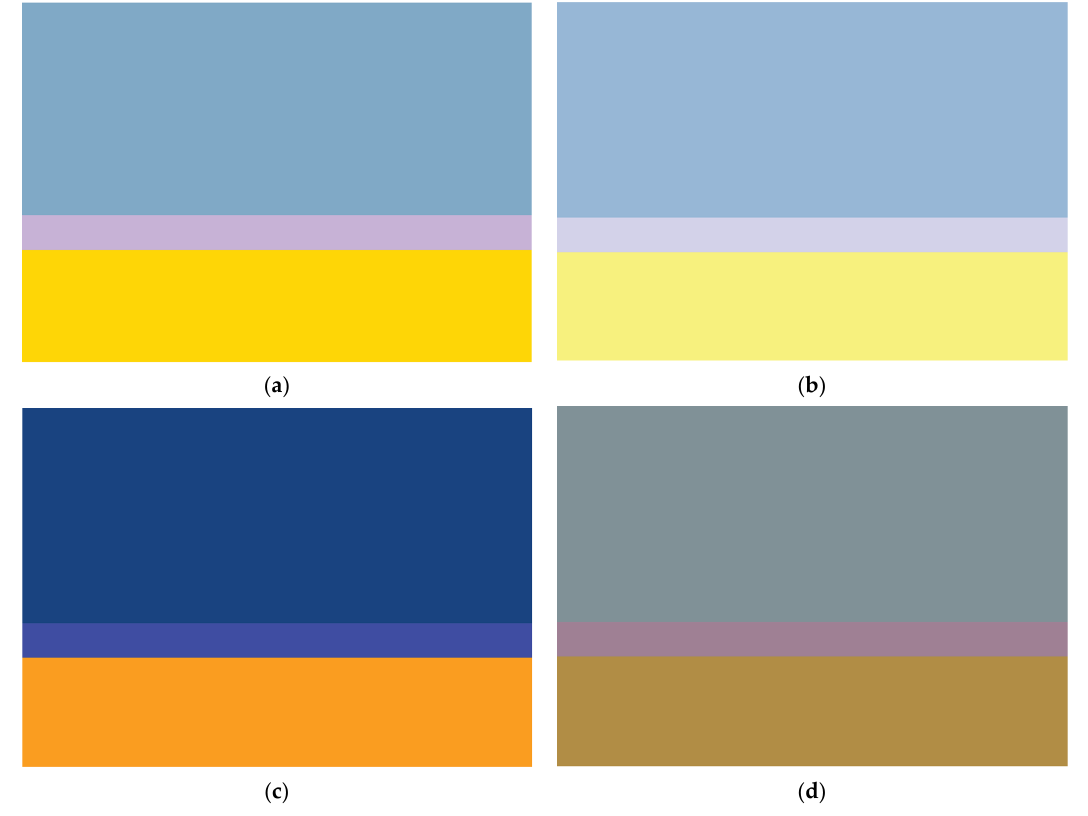
Figure 3. The sequentially first color charts in Sections I ( a ), II ( b ), III ( c ), and IV ( d ). As for hue, the main colors of the first three sections are fairly evenly distributed across the four quadrants of the color circle. Seven of them lie in the range between red and yellow (26.74 ≤ h° ≤ 71.83), six each fall between yellow and green (103.89 ≤ h° ≤ 149.89) and between green and blue (186.20 ≤ h° ≤ 265.14), and another five are situated between blue and red (281.31 ≤ h° ≤ 322.72). Warm colors (greens, yellows, oranges, and reds) have greater chroma than cold ones (blue-greens, blues, and purples) (Figure 4).